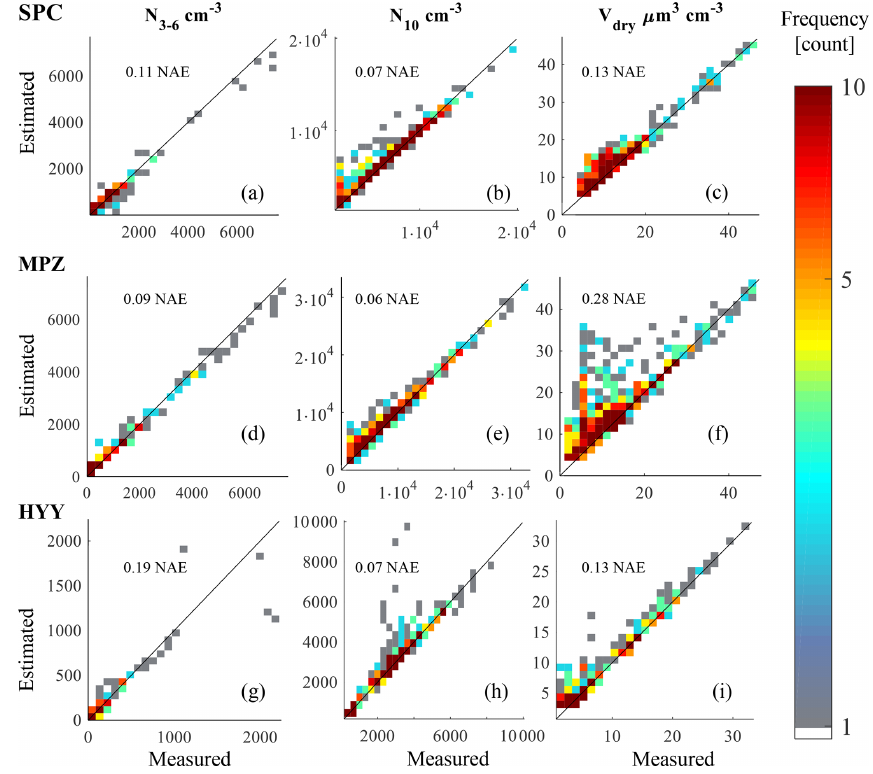
Figure 8. Frequency scatter plots comparing hourly estimates to hourly measurements of N 3–6 , N 10 , and V dry in the first, second, and third columns, respectively. Measurements from San Pietro Capofiume, Melpitz, and Hyytiälä are shown in the first, second, and third rows, respectively. The black line shows the 1:1 line. Normalized absolute error (NAE) is shown at the top of each